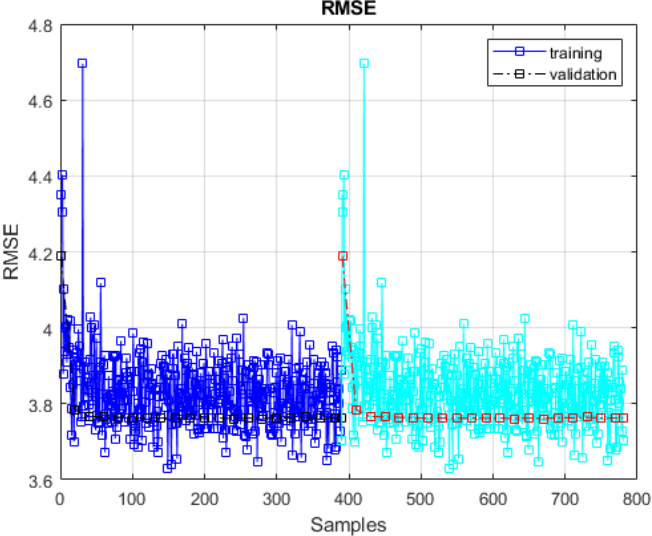
Figure 16. Network retraining RMSE